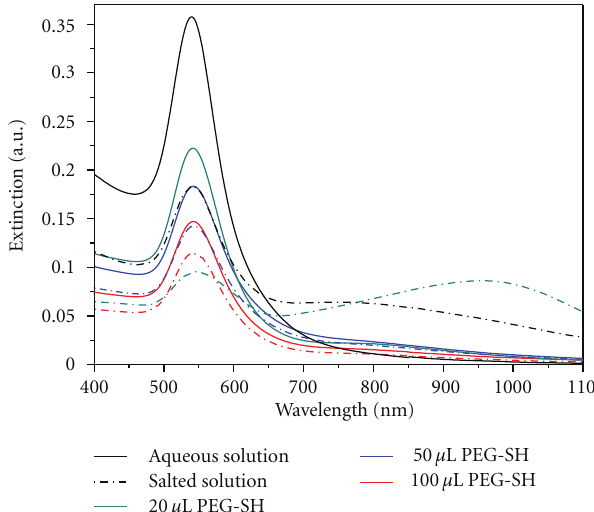
Figure 4: Extinction spectra of gold nanospheres ((GNSs) black line) and of PEGylated gold nanoensembles ((PEG-GENs) colored lines) recorded in the absence (thick lines) and in the presence (dotted lines) of 1M NaCl